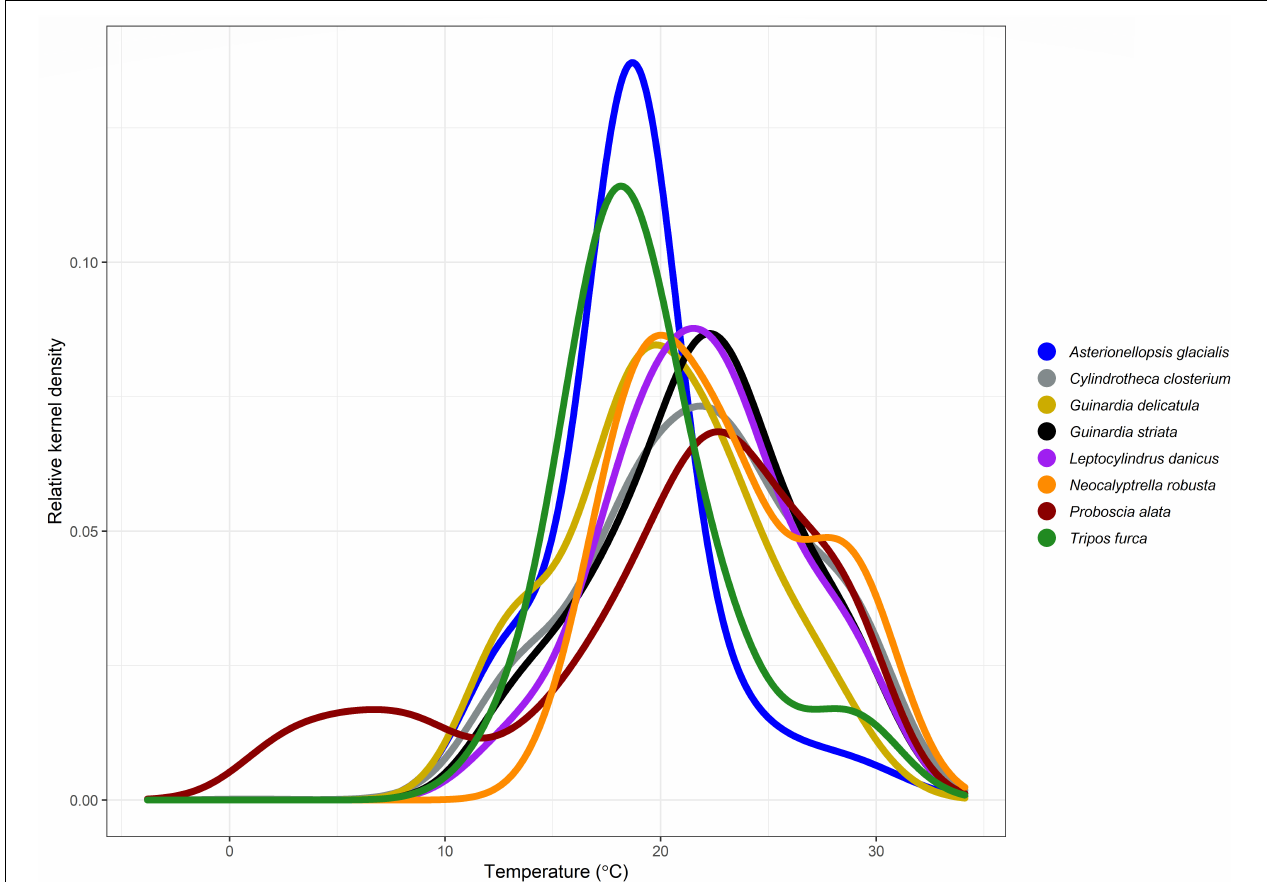
FIGURE 2 | Kernel density plots showing the temperature preferences (STIs) of the top eight most abundant species for each survey at PH 100m .